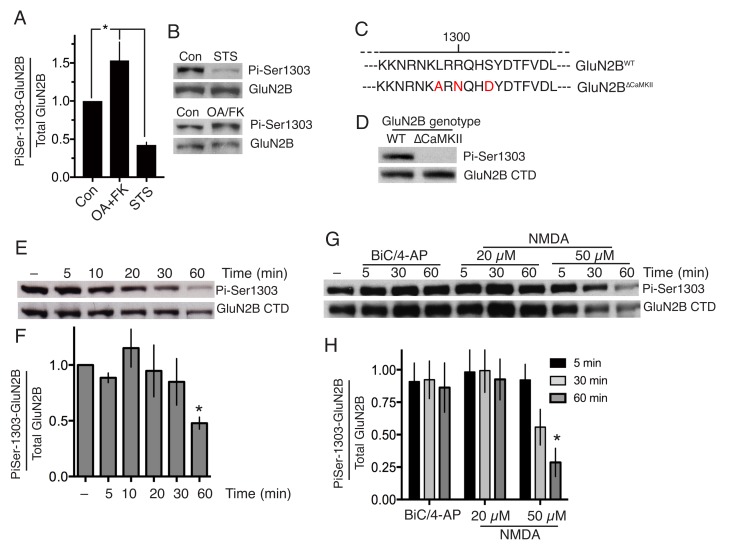
(A,B) Neurons were treated with staurosporine (STS, 1 µM) or FK-506 (FK, 5 µM)+okadaic acid (OA, 10 µM) for one hour, after which protein was harvested and western analysis for Phospho- (GluN2B Ser-1303) levels performed.p=0.0023 (1-way ANOVA). Individual P-values left-to-right: 0.026, 0.047 (n = 8 (FK +OA); n = 4 (STS). (C) Schematic depicting the amino-acid changes resulting from mutations of the Grin2b gene in the GluN2B∆CaMKII allele. (D) Example Phospho- (GluN2B Ser-1303) western blot illustrating the lack of immunoreactivity of the mutated domain in extracts from GluN2B∆CaMKII/∆CaMKII neurons. (E,F) timecourse of GluN2B Ser-1303 phosphorylation status in response to NMDA treatment (50 µM). F(5,10)=4.019, p=0.023 (one-way ANOVA). *p=0.041 (Sidak's post-hoc test (n = 3), 95% CI of diff 0.01897 to 1.024). (G,H) Experiment performed as per Figure 1a except neurons were at DIV16 rather than DIV10. F (2, 24)=5.324, p=0.0122 (two-way ANOVA). *p=0.0022 (Sidak's post-hoc test (N = 3)).